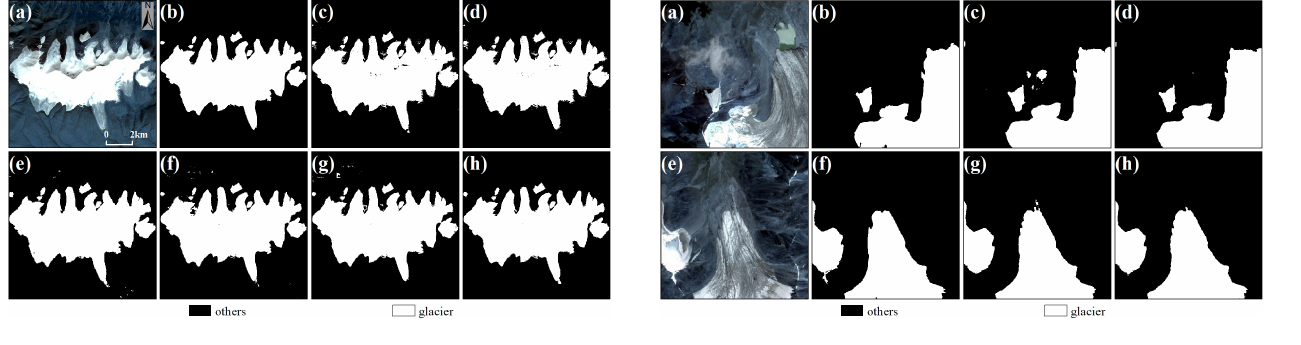
Figure 16. Examples of the results with and without TTA. Pan- els (a) and (e) are RGB images, (b) and (f) ground truth, (c) and (g) Attention DeepLab V3 + , and (d) and (h) Attention DeepLab V3 + with